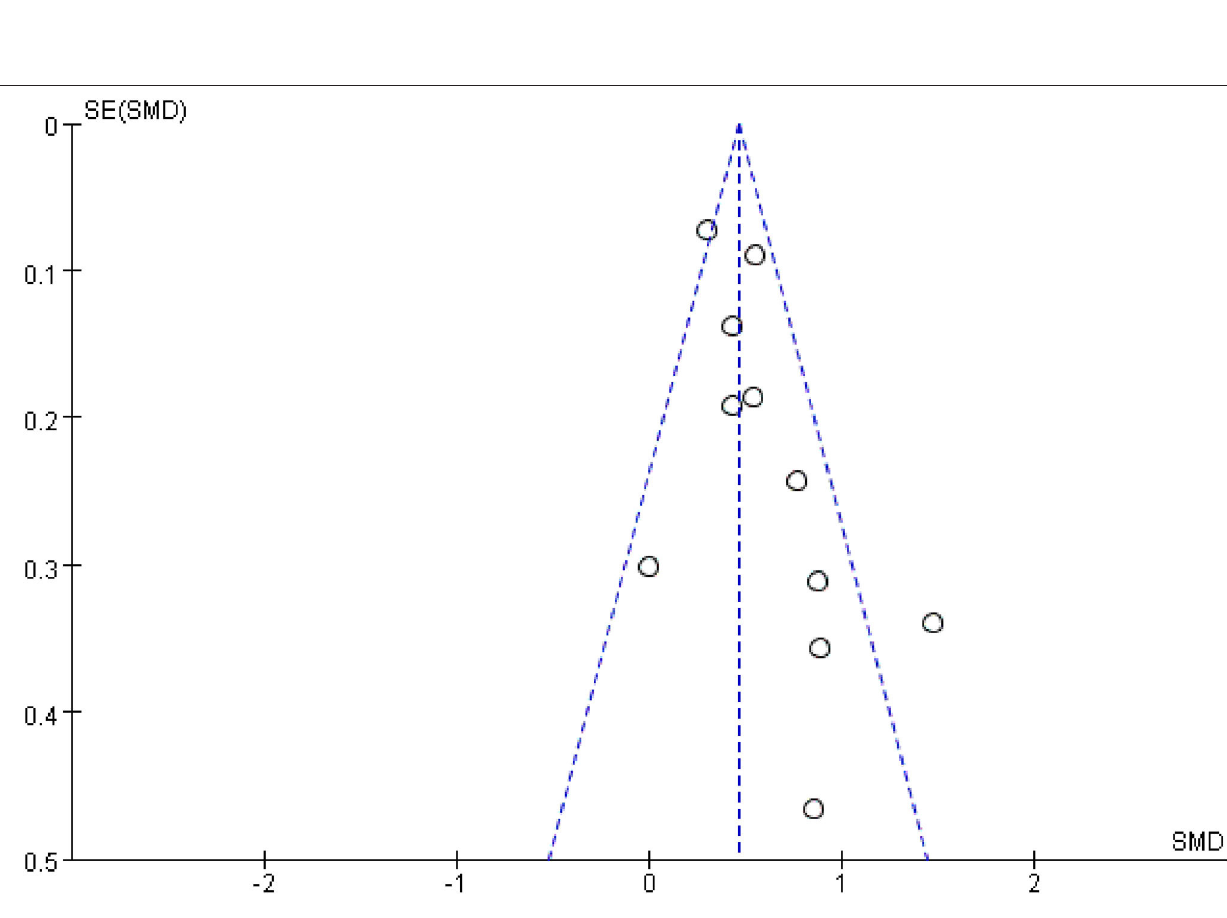
observational studies, and not of randomized control trials, could only support the potential association between increased SDC-1 and poor outcome in patients with